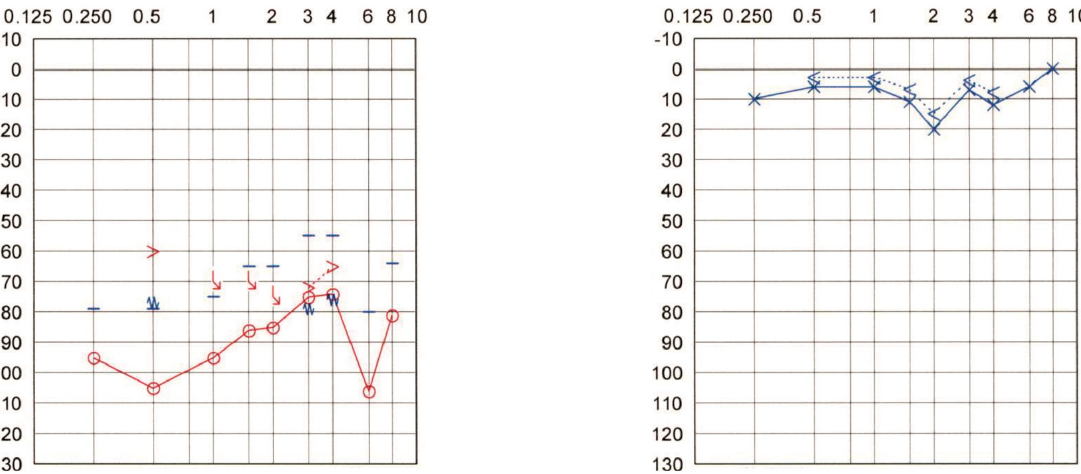
Figure 4. Pure tone audiogram of Patient #7 approximately ten years after right-sided sudden sensorineural hearing loss.